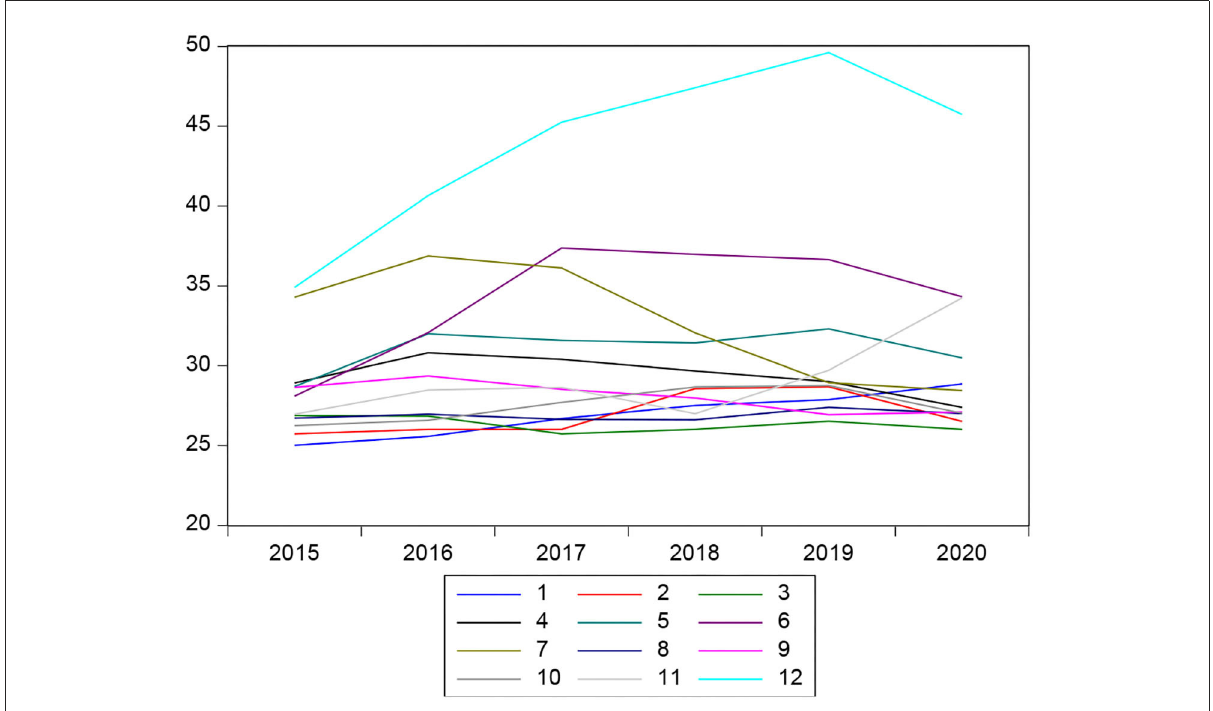
FIGURE4 Liquidity behavior of financial institutions.